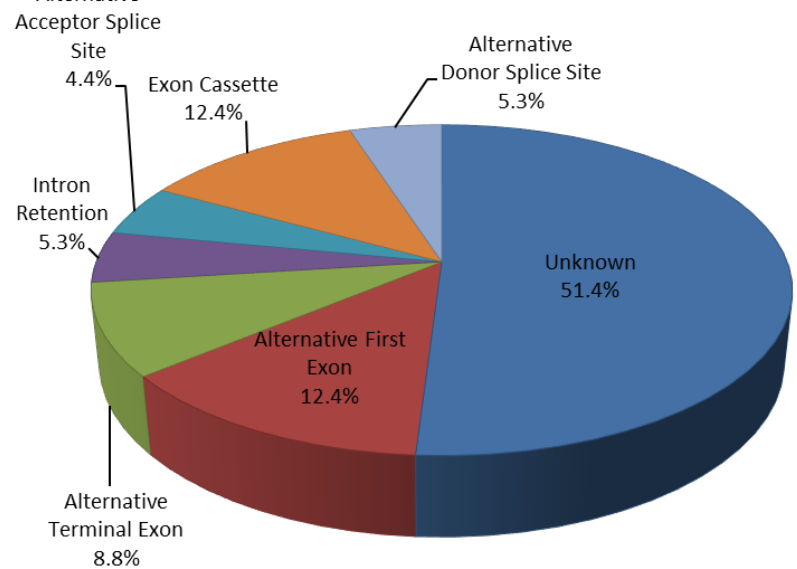
Figure 2. Alternative splicing events. Percentage of 113 differentially regulated alternative splicing events from 86 distinct genes: 4.4% Alternative Acceptor Splice Site; 12.4% Exon cassette; 5.3% Intron retention; 5.3% Alternative Donor Splice Site; 8.8% Alternative Terminal Exon; 12.4% Alternative First Exon; 51.4% unknown. Table 2 . Number of AS regulated events.